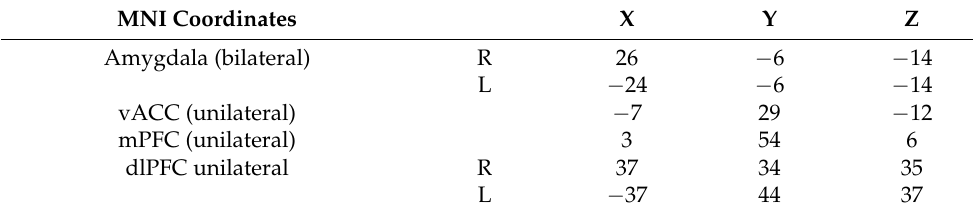
Figure 2. Amygdala–frontal network: representation of the ROIs. For the analyses, we assessed the rsFC of the amygdalae (in green) with one of the other ROIs (in orange), namely the ventral anterior cingulate cortex (vACC, unilaterally), the medial prefrontal cortex (mPFC, unilaterally), or the dorsolateral prefrontal cortex (dlPFC, bilaterally). Table 1. MNI coordinates of each ROI.